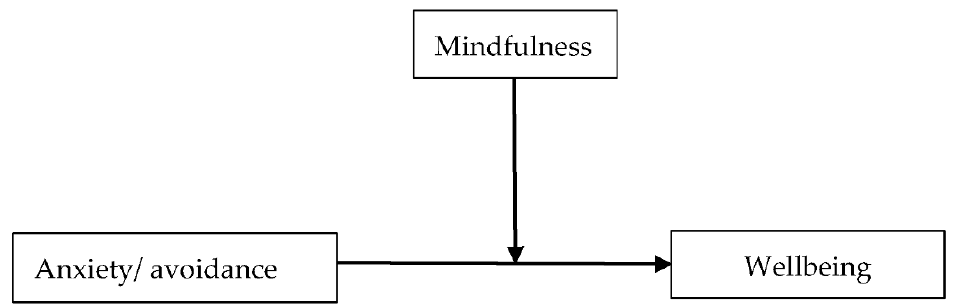
Figure 1. Theoretical model of moderation between anxiety and avoidance in intimate relationships and psychological wellbeing, understanding the role of dispositional mindfulness. Bootstrap intervals were obtained to verify the significance of the mediating effects at a level of significance of 5%. PROCESS macro in SPSS software, version 22 (Hayes 2014) was used.